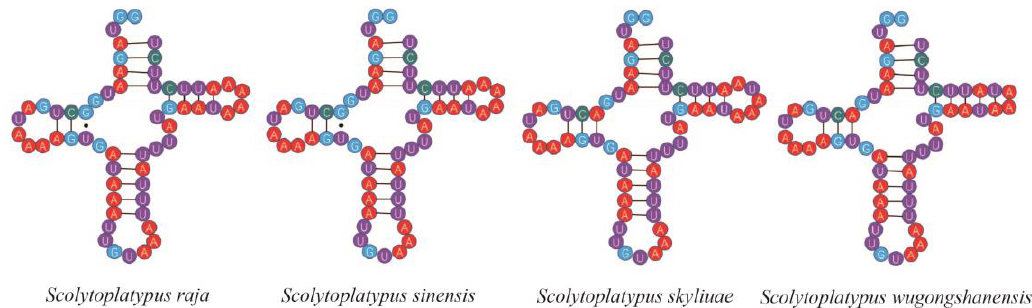
Figure 4. Secondary structures of the trnY in Scolytoplatypus mitogenomes.